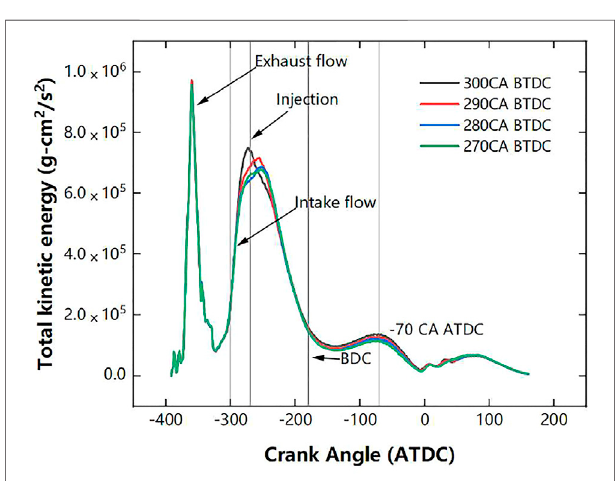
FIGURE 5 | Effect of injection timing on total kinetic